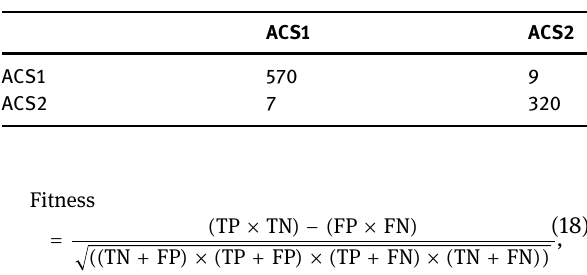
Table 2: Confusion matrix for the system